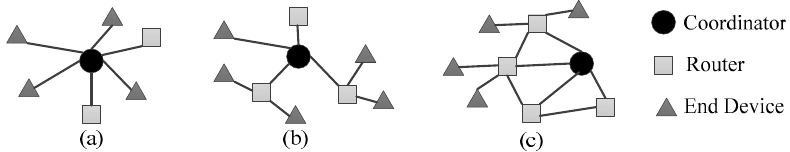
Figure 3. ZigBee network topologies: ( a ) star, ( b ) tree, and ( c ) mesh.